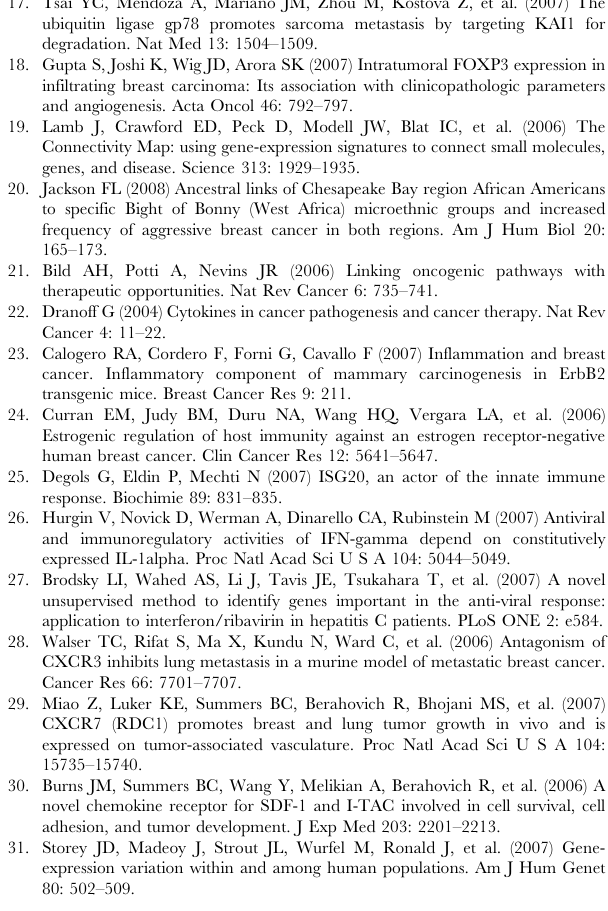
Figure S1 Disease association analysis. Shown is a heat map. The list of differentially expressed genes (P # 0.01) comparing tumor epithelium from African-American breast cancer patients (AA) with tumor epithelium from European-American patients (EA) was analyzed for their relationship with other diseases using the genetic association database. The red color indicates common associations between differentially expressed genes in a gene list, e.g., AA versus EA (all tumors), and other diseases. The disease association analysis was performed for four gene lists: AA (n=18) versus EA (n=17) for all tumors combined; AA (n=13) versus EA (n=5) for ER-negative tumors, AA (n=5) versus EA (n=11) for ER-positive tumors and ER-positive (n=16) versus ER-negative tumors (n=18). Red color intensity is a surrogate for the strength of the association.